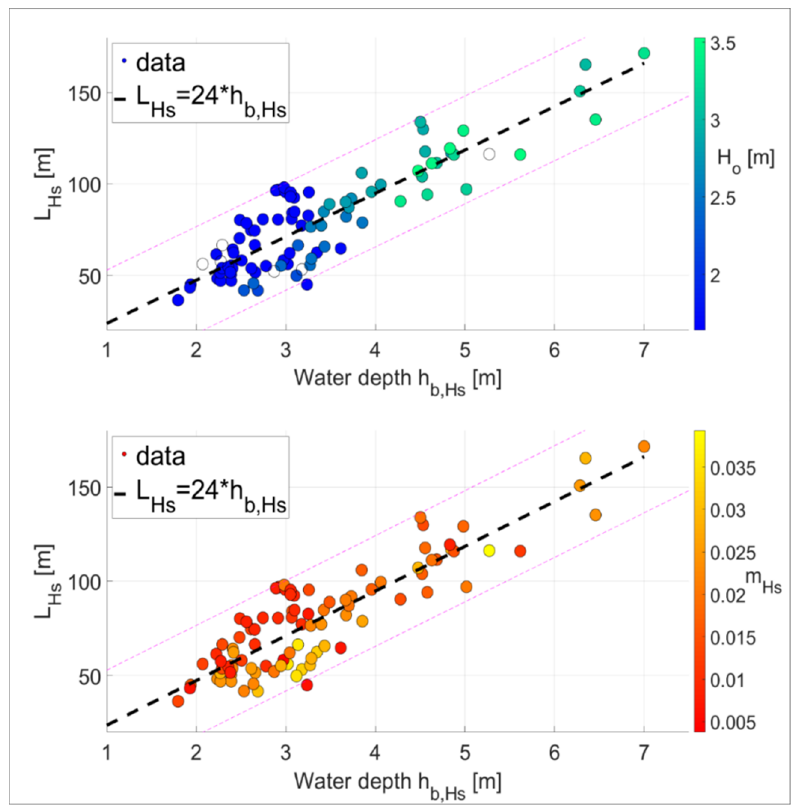
Figure 7. L Hs versus water depth h b , Hs , with dependence (colors) of o ff shore wave height ( top ) and Figure 7. 𝐿 (cid:3009)(cid:3046) versus water depth ℎ (cid:3029),(cid:3009)(cid:3046) , with dependence (colors) of offshore wave height ( top ) and slope under breaking conditions m Hs ( bottom ). Black dashed lines indicate the best fitting y = ax. slope under breaking conditions 𝑚 (cid:3009)(cid:3046) ( bottom ). Black dashed lines indicate the best fitting y = ax. Dashed magenta lines represent upper and lower 95% prediction Dashed magenta lines represent upper and lower 95% prediction bounds.